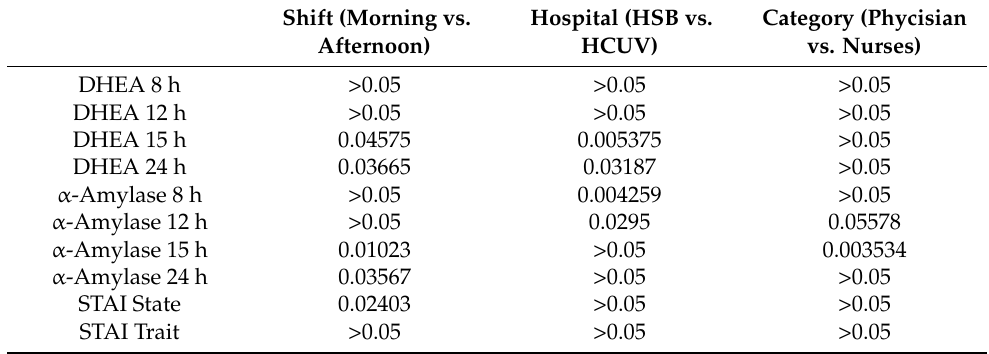
Table 5. p -values for all comparisons for the variables, moment, category and hospital analysed. Shift (Morning vs. Hospital (HSB vs. Category (Phycisian Afternoon) HCUV) vs. Nurses) DHEA 8 h >0.05 >0.05 >0.05 DHEA 12 h >0.05 >0.05 >0.05 DHEA 15 h 0.04575 0.005375 >0.05 DHEA 24 h 0.03665 0.03187